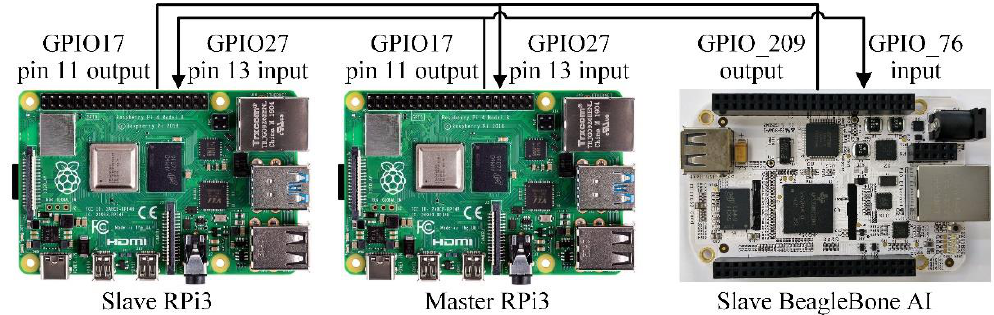
Figure 8. Schematic diagram of system connections: RPi3 to RPi3 and RPi3 to